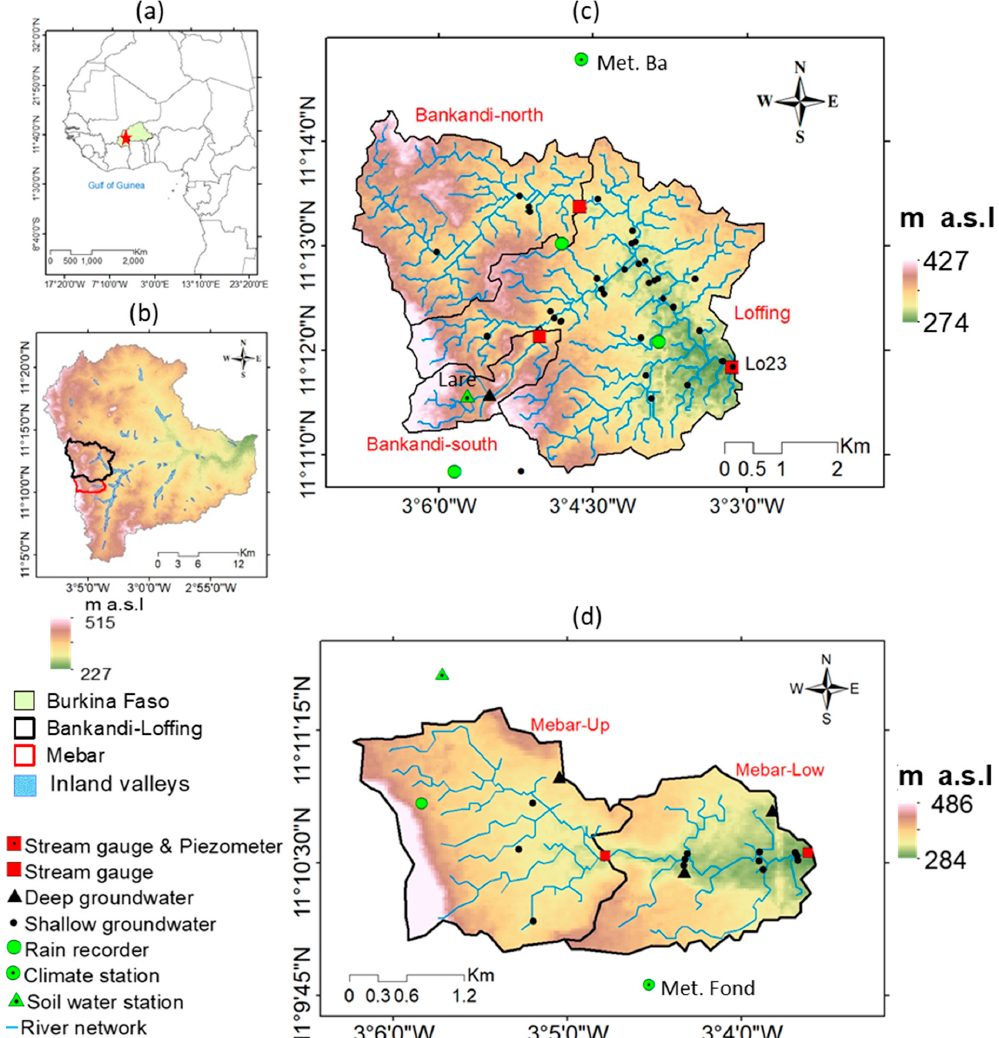
Figure 1. Location, topography, and instrumentation of the investigated catchments. ( a ) Location of the Dano catchment in Burkina Faso; ( b ) Bankandi ‐ Loffing and Mebar catchments in Dano; ( c ) Sub ‐ catchments and instrumentation of the Bankandi ‐ Loffing catchment; and ( d ) Sub ‐ catchments and instrumentation of the Mebar catchment (Digital Elevation Model: [64]; country outlines ( a ): [65]). According to the soil classification of the World Reference Base [66], Plinthosols are the predominant soil types in the investigated area (Figure 2). They cover 50% of the Mebar catchment area and 73% of the Bankandi ‐ Loffing catchment area. Cambisols and Gleysols are the second most observed soil types in the area. Cambisols and Gleysols account for 29% and 9% of the Mebar catchment, respectively, and each of the Cambisols and Gleysols represent 11% of the Bankandi ‐ Loffing catchment. The texture of Plinthosols varies with soil depth from loam to clay whereas for Gleysols and Cambisols, the texture changes from clay loam or silt loam to silt clay loam. Plinthosols are frequently observed in uplands of inland valleys while Gleysols and Cambisols are located in the valley bottoms.